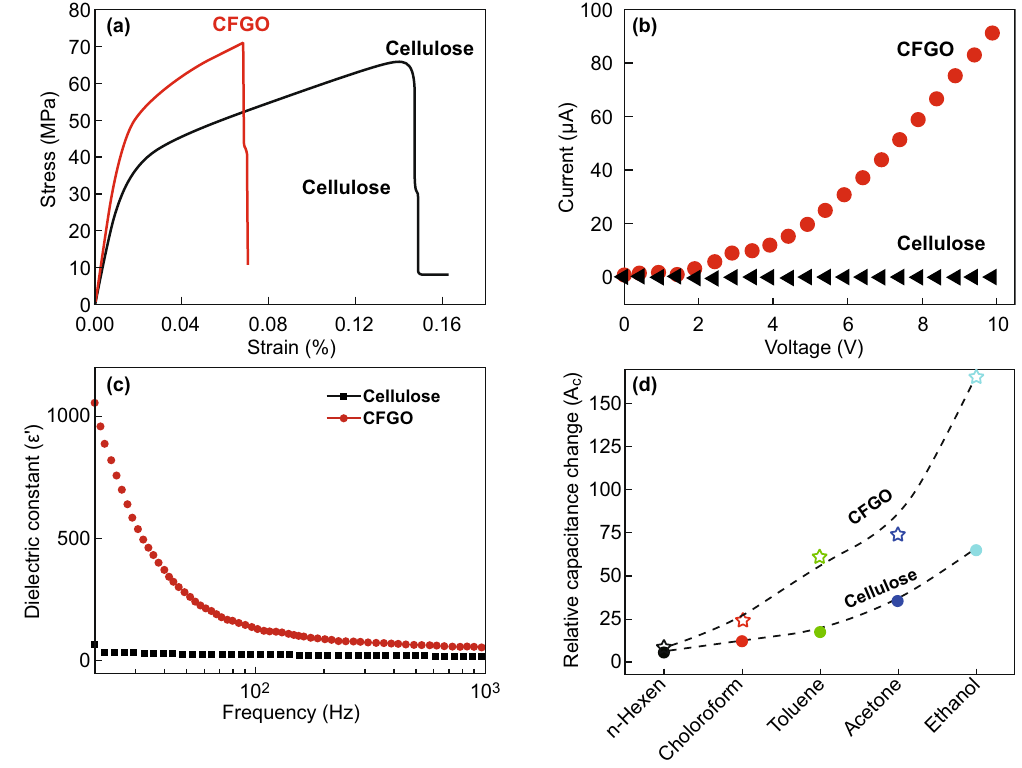
Fig. 21 a – c Mechanical, electrical, and dielectric properties of NCs-GO hybrid film and d Relative capacitance change ( A C ) of NCs-GO hybrid film with several solvents. Reproduced with permission from Ref. [33] Copyright © 2015, Elsevier